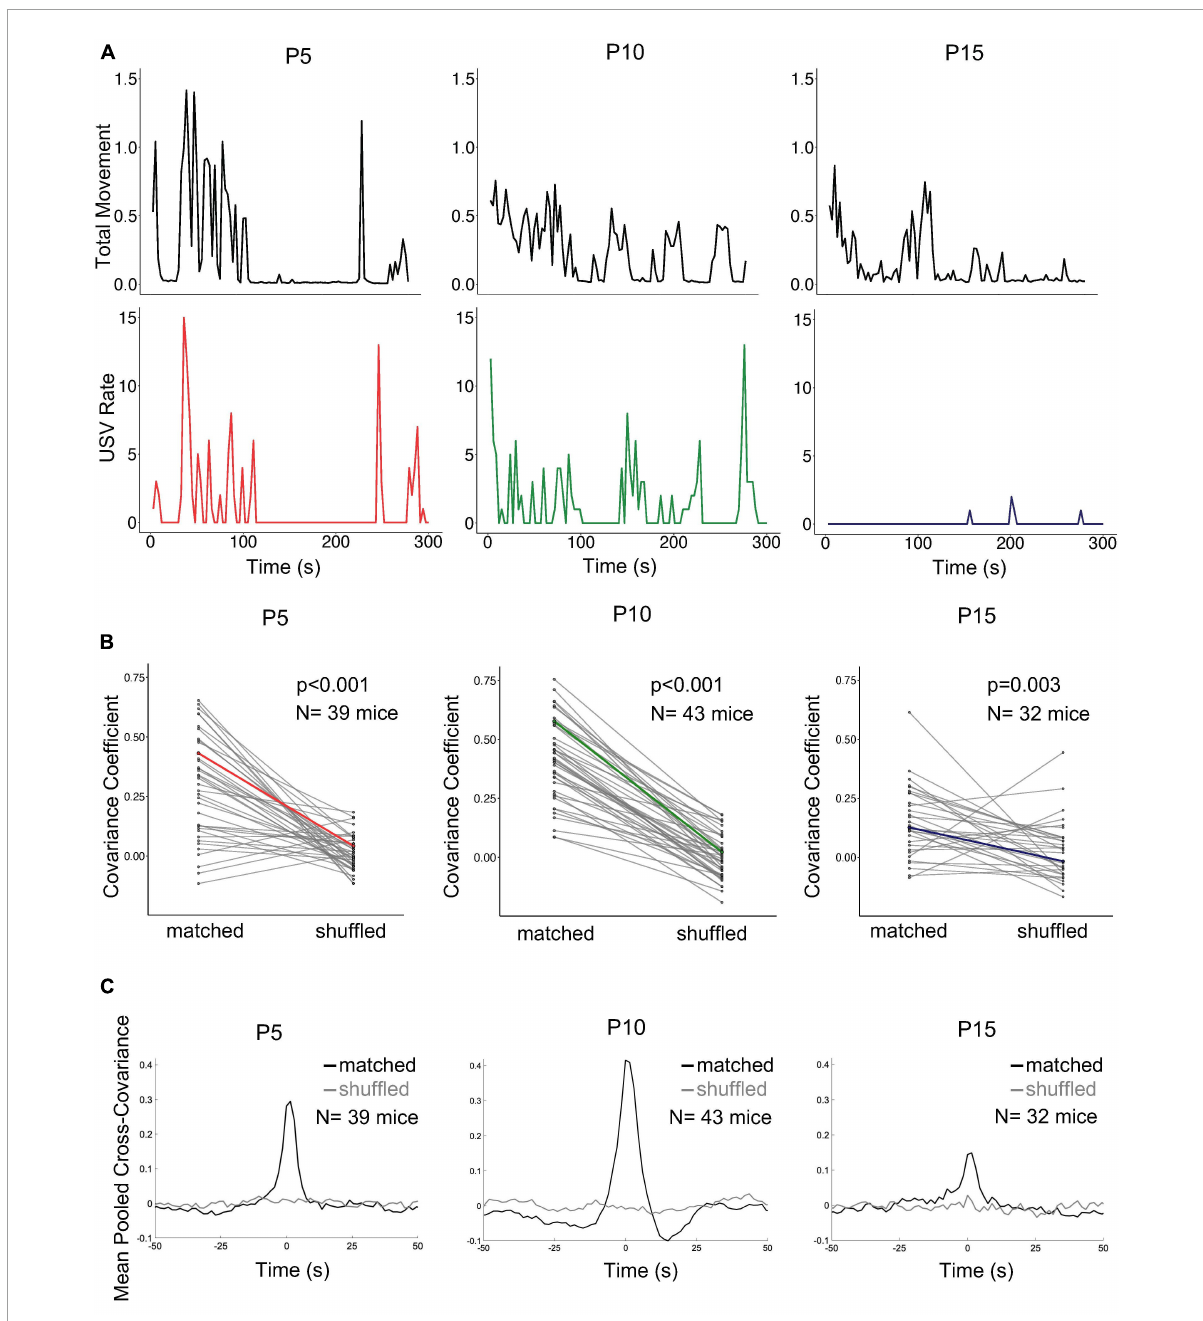
FIGURE5 Relationship of USV rates to intensity of non-vocal movements. (A) Plots of non-vocal movement intensity (top row) and USV rate (bottom row) are shown for three representative trials. P5, left ( N = 39); P10, middle ( N = 43), P15, right ( N = 32). (B) Covariance coefficients for matched and shuffled comparisons are plotted for each mouse in each postnatal age group. Colored lines correspond to the examples shown in (panel A ). (C) Mean pooled matched (black) and shuffled (gray) cross-covariances are shown for the comparison of movement intensity and USV rate in the three postnatal age